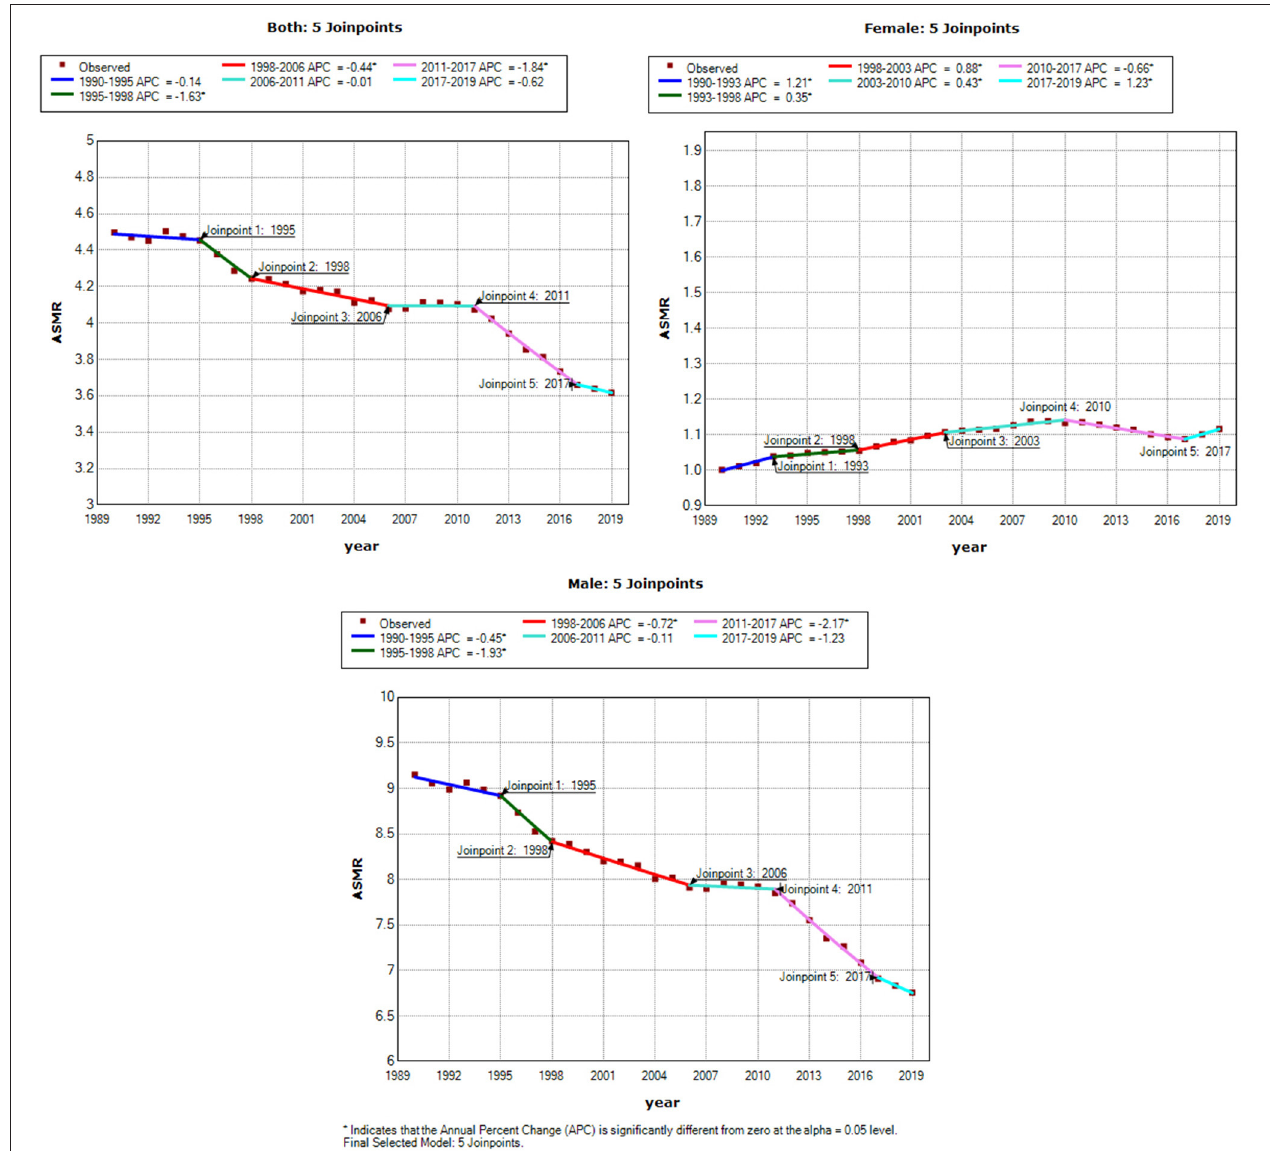
FIGURE 3 | Joinpoint analysis of trend in age-standardized mortality rates (ASMR) of tracheal, bronchus and lung cancer exposure to occupational carcinogens. APC, the annual percentage